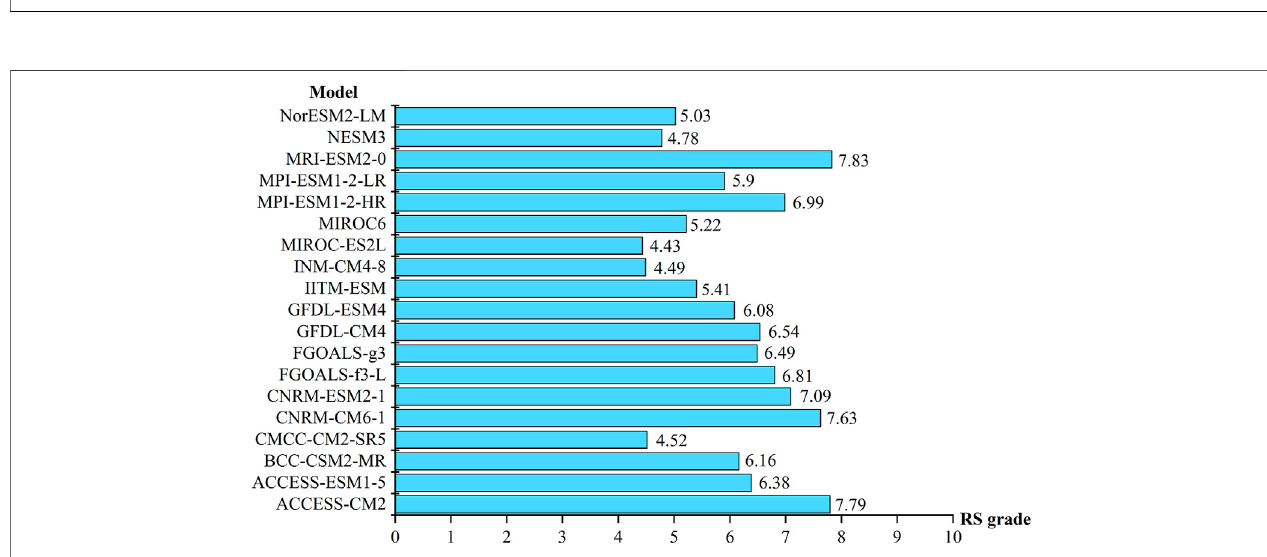
FIGURE 1 | Meteorological grid and river system of the Yellow River Basin.